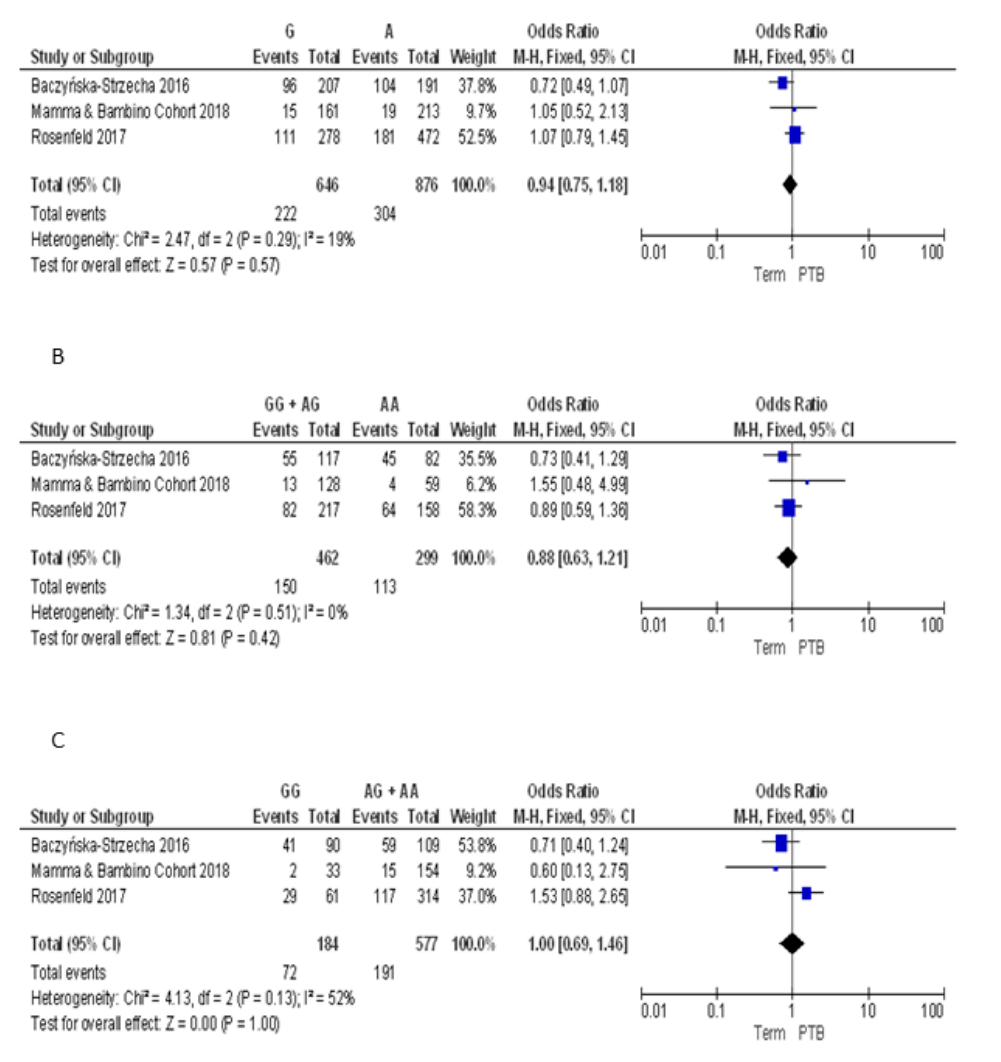
Figure 6. Forest plots of the association between TaqI polymorphism and preterm birth under the ( A ) allelic, ( B ) dominant and ( C ) recessive models.